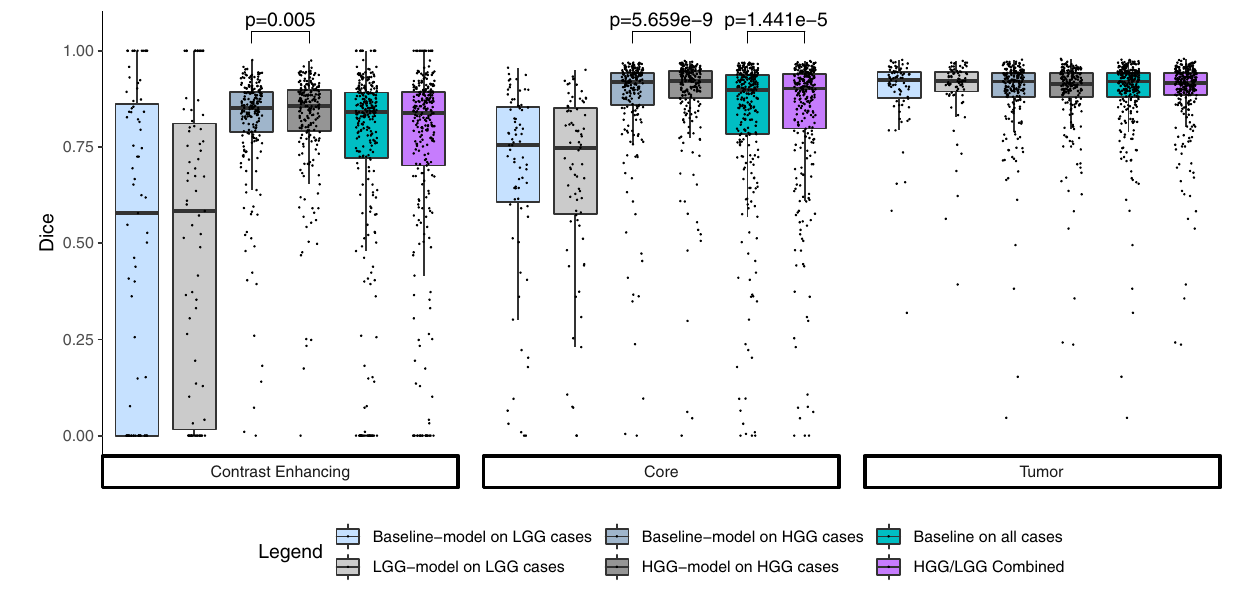
phenotype (e.g., IDH-mutant tumor, presence of intratumoral hemorrhage, or cystic components) which causes distinctively different image appearances.